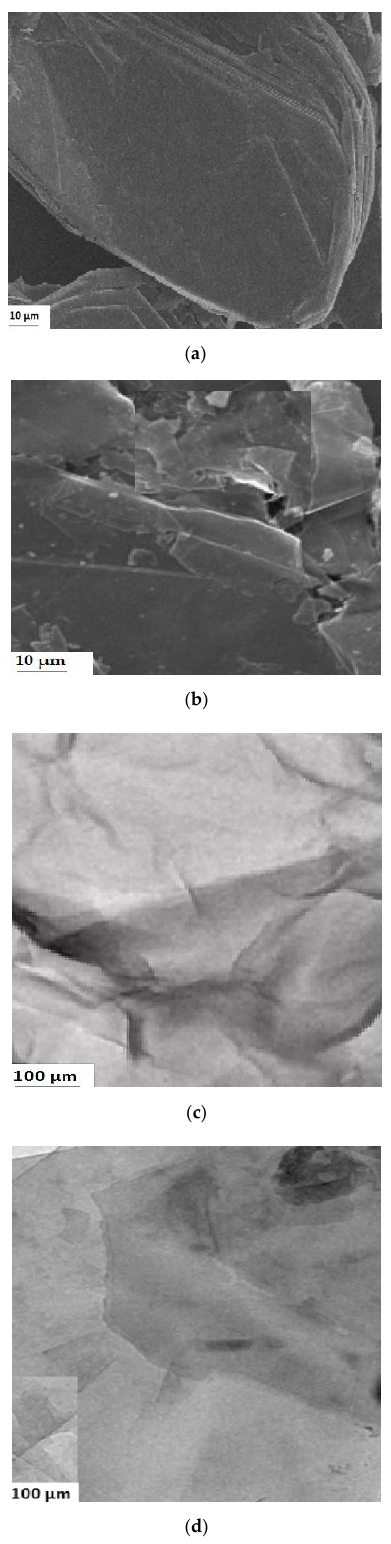
Figure 8. Scanning Electron Microscopy (SEM) of ( a ) Gr ( b ) GO, and transmission electron microscopy (TEM) of ( c ) Gr ( d ) GO. Images corresponding to transmission electron microscopy (TEM) spectra were also taken to analyze the material in detail on the surface of Gr and GO. It can be seen that monolayers have been easily isolated from the starting samples. In the images, it is shown how the structure of the